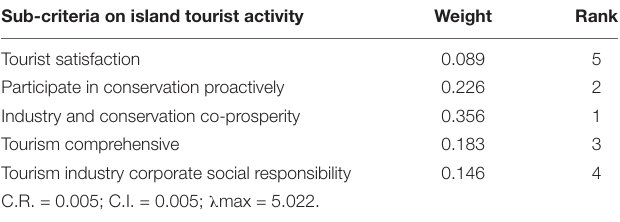
TABLE 8 | Key indicators of island tourist